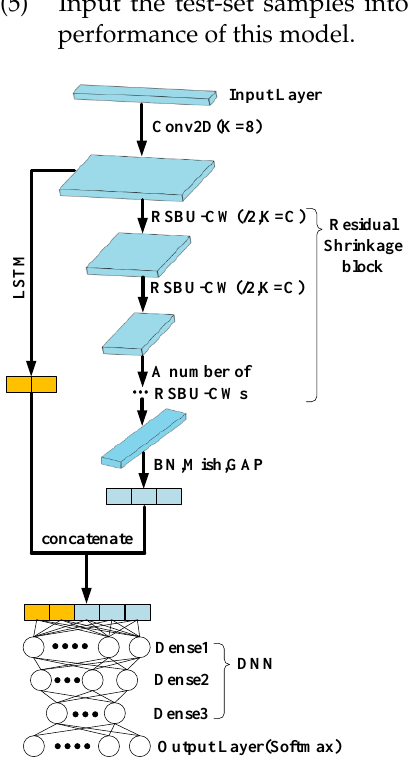
Figure 4. Complete structure of proposed